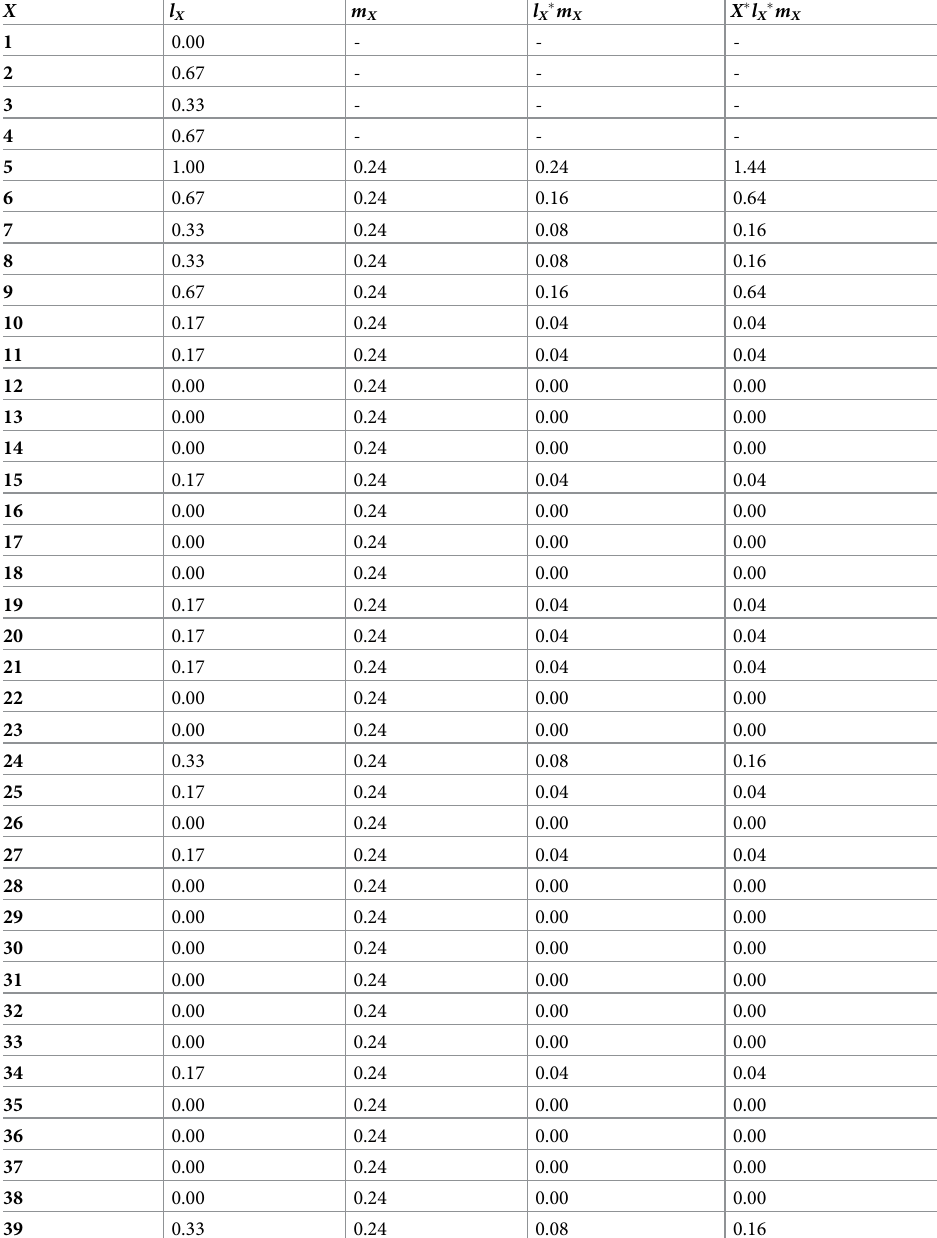
Table 7. Fertility table of P . flavus BM